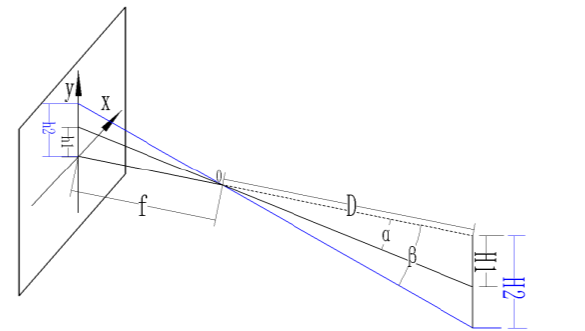
Figure 6. Camera imaging model.